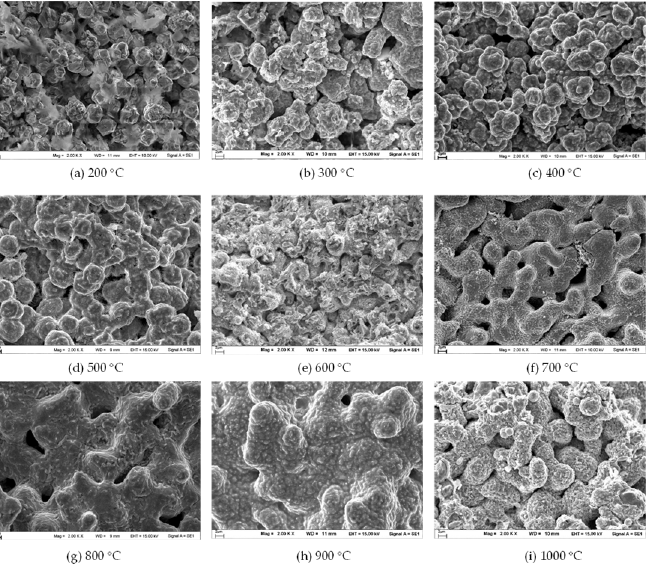
Figure 3. SEM photographs of micro-copper clay fired at different temperatures: ( a ) 200 °C, ( b ) 300 °C, ( c ) 400 °C, ( d ) 500 °C, ( e ) 600 °C, ( f ) 700 °C, ( g ) 800 °C, ( h ) 900 °C, and ( i ) 1000 °C.